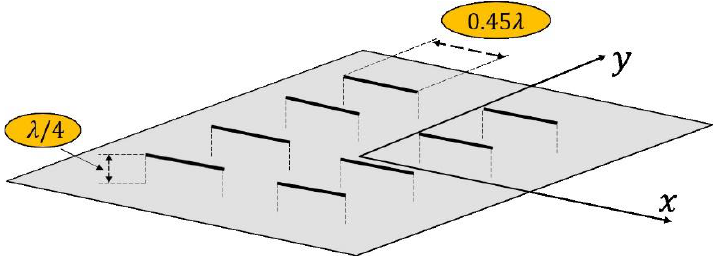
Figure 2. Detail of an array of center-fed electric dipoles set λ /4 above an infinite ground plane introduced in the study by means of its element factor [7,30].